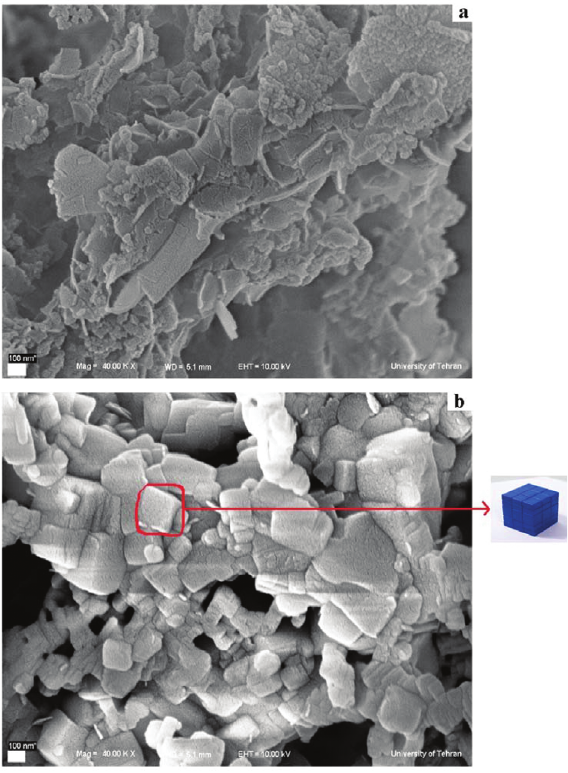
Figure 6: SEM image of the bismuth ferrite prepared in the presence of (a) 0.7 and (b) 2 g PVP.